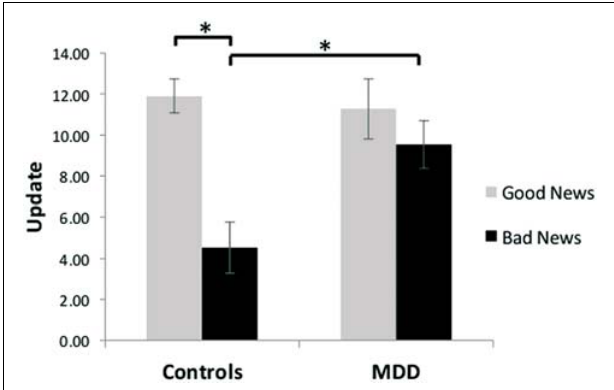
FIGURE 2 | Unbiased updating in MDD, but biased updating in controls. After receiving good news that presented an opportunity to adjust beliefs in a positive direction, healthy participants updated their estimations to a greater extent than after receiving bad news that called for adjustments in a negative direction. In contrast, depressed participants updated their beliefs to a similar extent after receiving good and bad news, and updated their beliefs more than healthy individuals when receiving bad news. Error bars represent SEM * p < 0.05, two-tailed independent/paired samples t -test.